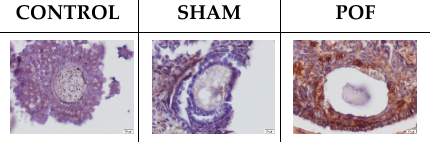
Figure 2. Representative images of TUNEL analysis results for all groups (Scale bar: 10